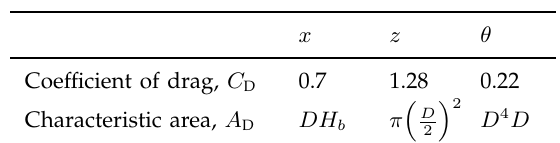
TABLE II D RAG PROPERTIES